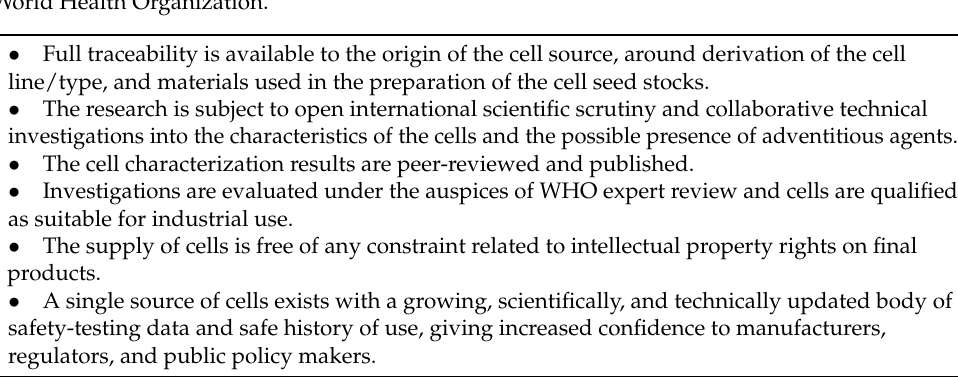
Table 3. Summary of the various criteria to be met by specific cell types or sources in view of proposition thereof as WHO reference cell banks. Such cells banks are specifically designed to offer potential solutions to emerging challenges in the development of vaccines and biotherapeutics. The specific technical purpose of such cell banks is to be able to sustainably provide medicinal product manufacturers with well-characterized cell seed materials to be used for establishing manufacturer MCBs, to be further characterized and appropriately qualified [53]. MCB, master cell bank; WHO, World Health